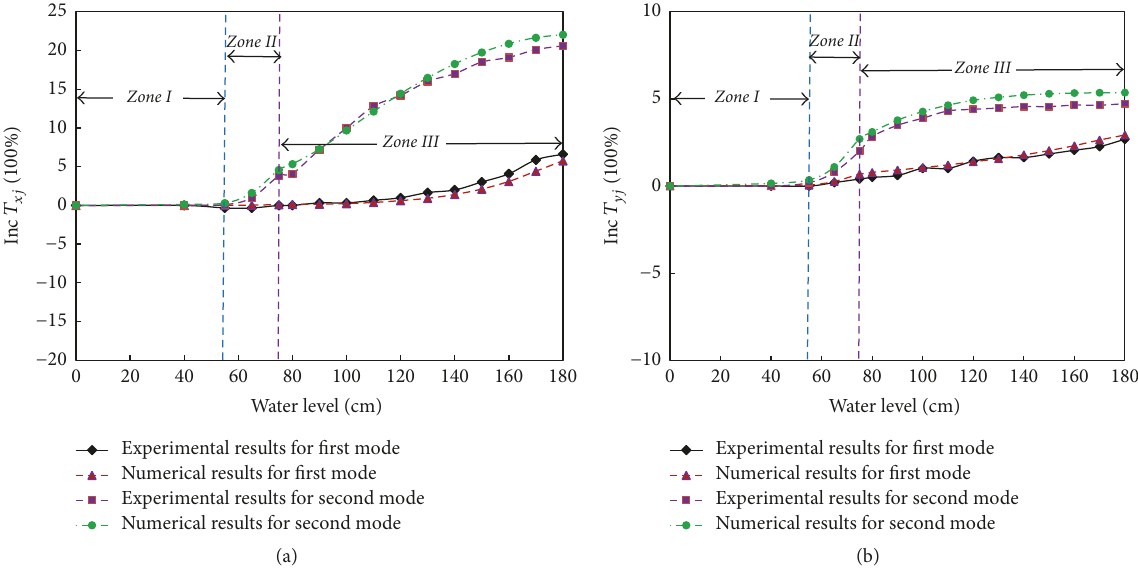
Figure 14: Measured and computed period percentage increases for the pier specimen with a 23.4 kg tip mass as a function of water level: (a) the first two lateral modes along 𝑥 -axis; (b) the first two lateral modes along 𝑦 -axis.